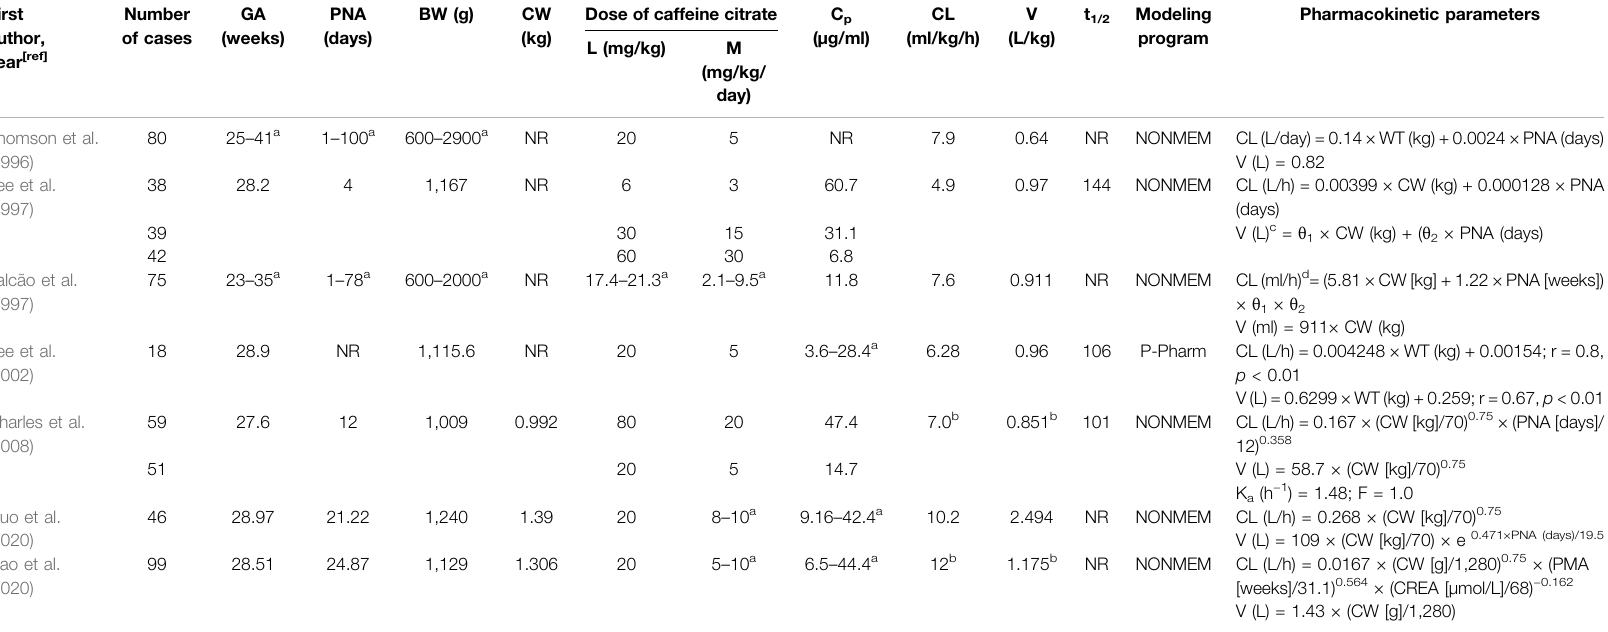
TABLE 2 | Population pharmacokinetics of caffeine in preterm